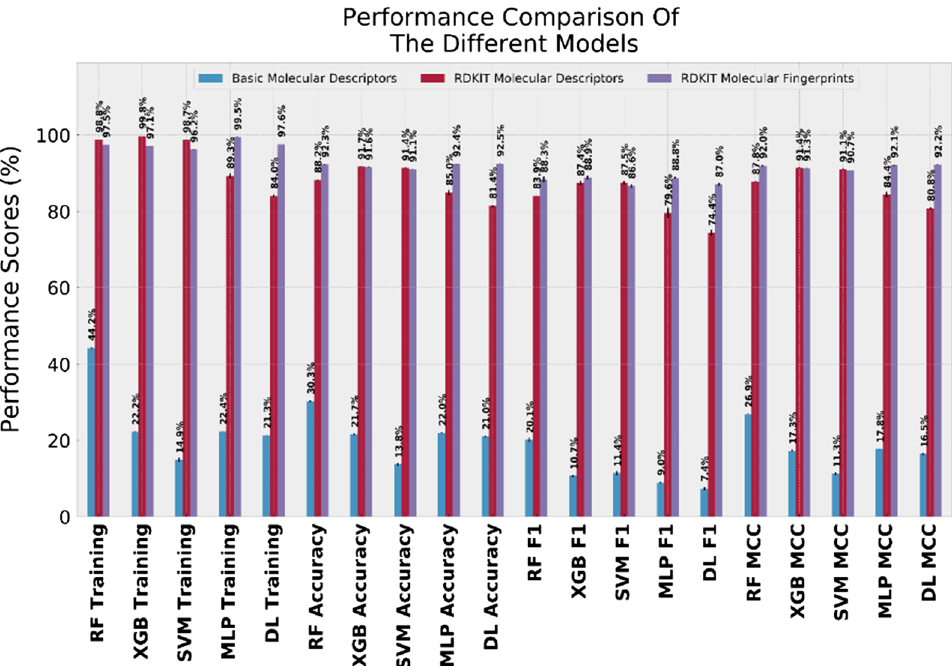
Figure 5. Performance scores of the 5 different machine learning models considered in the current study. Reported scores represent the average performance of the 5 repetitions on the independent test dataset. In each repetition, data is split according to the 70/30 protocol. The figure was generated with Python Matplotlib 3.2.1: https:// matpl otlib.